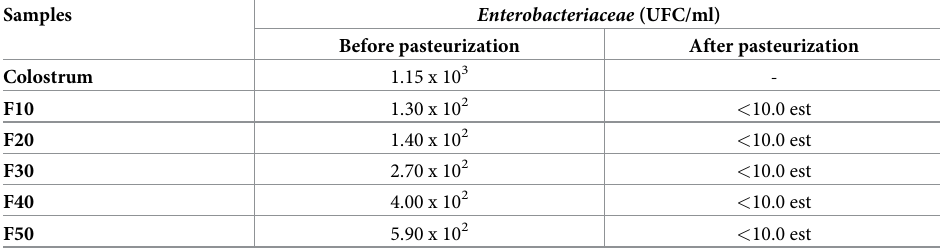
Table 6. Microbiological analysis of Enterobacteriaceae before and after pasteurization.